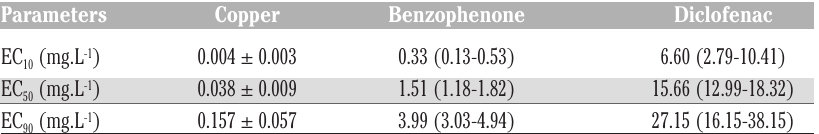
Table 1. Acute toxicity of copper, benzophenone and diclofenac to G. pectinatus with 95% confidence intervals.